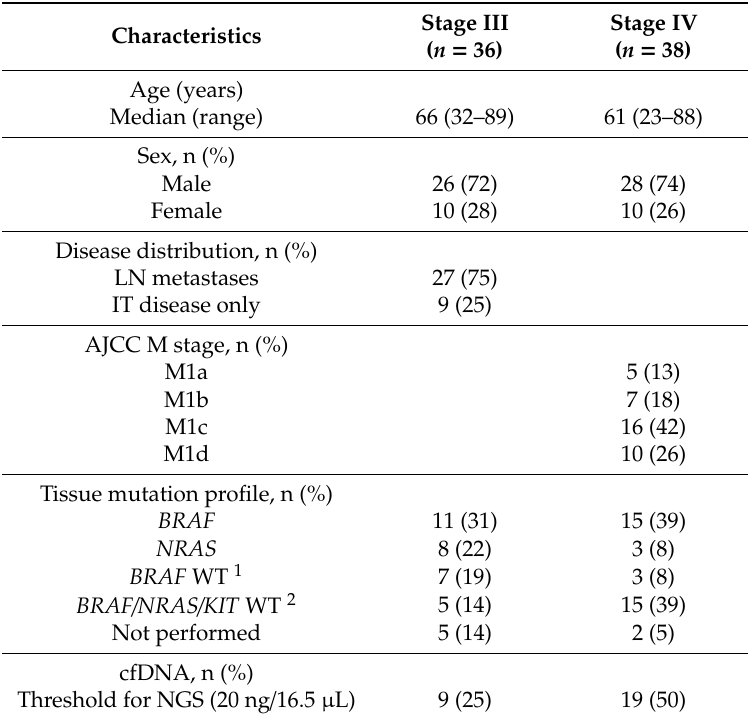
Table 1. Summary of patient cohort.